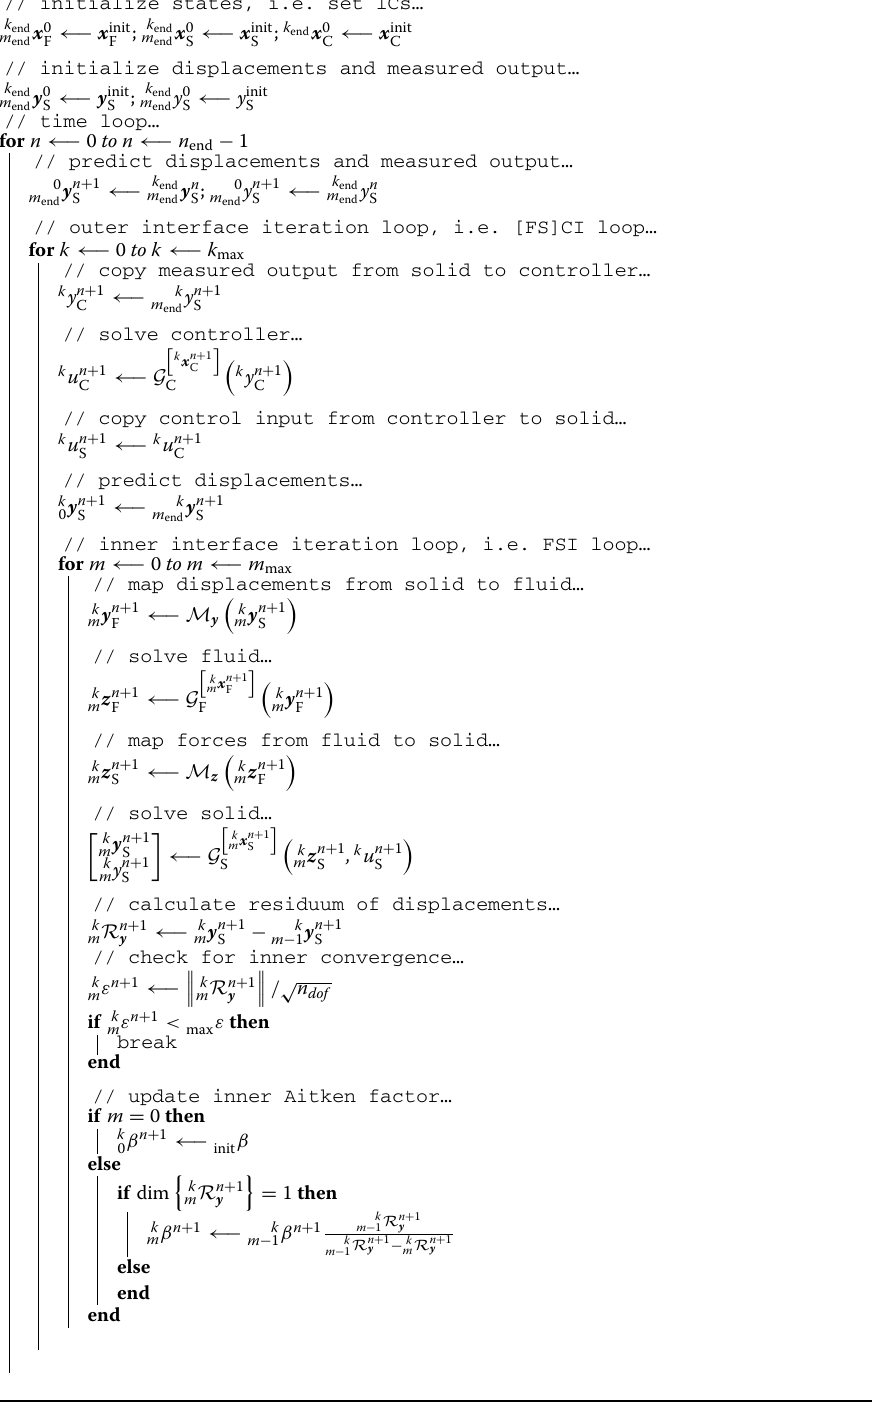
Algorithm 2: Pseudocode for the partitioned [FS]CI scheme (nesting of [FS]